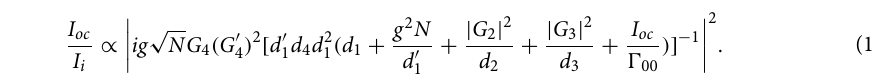
(cid:31) (cid:31) (cid:31) 0 and (cid:31) 1 0 , where the eigen- 1 1 1 + + + + +± = − = (cid:31) (cid:31) (cid:31) (cid:31) 2 and (cid:31) 2 . (� 2 )/ 2 (� 2 ) 2 / 4 � 5 / 2 � 2 / 2 G 2 G 5 values are (cid:31) 1 2 1 2 1 2 5 | +| | + ± (cid:31) + ± (cid:31) + | +± = ± − + ± − + ± = Figure 6(b1) reveals a positive correlation between output intensity and input intensity as well as a slight increase bend of output curves when I i increases from 100 to 200 and to 500. The inclined curves origin from the feed- back effect of both three-photon dressed effects and cavity field g 2 N . As (cid:31) 1 increases, the fast growth of right (cid:31) 1 threshold of OB obtained in Fig. 6(c1). Figure 6(d1) demonstrates the enlarging OB scope with increased , | | where the right thresholds sharply increase with slight growth in the left threshold. Besides, we observed that 0 MHz and � 1 /Ŵ 20 20 , for obeying there are two points of no OB behavior at or close to the points (cid:31) 1 = = − (cid:31) (cid:31) (cid:31) 2 (cid:31) 2 0 and (cid:31) 1 0 , respectively. The phenomenon of no dark resonance conditions (cid:31) 1 2 2 + + + + + = − = OB resulted from the disappearance of dispersion effect induced by the nested three-photon interaction. In short, the OB behavior of three peaks and two points of no OB behavior distributed asymmetrically at the center of (cid:31) 1 0MHz under the nested interaction. = Next, we research the role of cascade interaction in OB and compare the difference with nested interac- tion. As the coupling fields E 2 and E 3 work as dual two-photon dressed effect, the symmetrical distribution of 0 MHz is obtained. Figure 6(a2) displays four split OB intensity peaks at sym- OB peaks at the center of (cid:31) 1 = (cid:31) (cid:31) 0 , metrical distribution. Similarly, the four peaks satisfy four enhancement conditions (cid:31) 1 1 1 + + + ++ = (cid:31) (cid:31) (cid:31) (cid:31) (cid:31) (cid:31) (cid:31) 1 0 , (cid:31) 1 0 and (cid:31) 1 0 , where the eigenvalues are 1 1 1 1 1 1 + + + + + +− = − + −+ = − + −− = (cid:31) (cid:31) (cid:31) (cid:31) (cid:31) 2 and (cid:31) 2 . (� 2 )/ 2 (� 2 ) 2 / 4 (� 3 )/ 2 (� 3 ) 2 / 4 G 2 G 3 1 1 1 1 1 1 | | +| +| − ± (cid:31) − + ± (cid:31) + +± = + + −± = − − − Figure 6(b2) shows the positive correlation of the output intensity and input intensity, which is in the same situation of the nested type. Figure 6(c2) displays the strongly growth of right threshold as (cid:31) 1 increases. The changing relationship of output intensity with (cid:31) 1 is agree with the nested interaction. The obvious OB behavior contrasts with nested type is that there is an unchanged OB scope with similar growth trend of right threshold and left threshold presented in Fig. 6(d2), and there are another two broadened OB scopes with fast growth of right thresholds and slowly changed left thresholds. In addition, the two points of no OB located around the pos- (cid:31) 3 (cid:31) 2 0 , which resulted from 0 and (cid:31) 1 10, 10 obey dark resonance conditions (cid:31) 1 its of � 1 /Ŵ 20 − = + = = − the cascaded dual two-phonon interaction and leaded the disappearances of dispersion effect. The OB behavior under the work of cascaded interaction with four peaks and two points of OB distributed symmetrically at the 0MHz . That is to say, the indirect dressed effect of E 5 in nested interaction and direct dressed center of (cid:31) 1 = effect of E 3 in the cascaded interaction lead to the different distribution of OB.